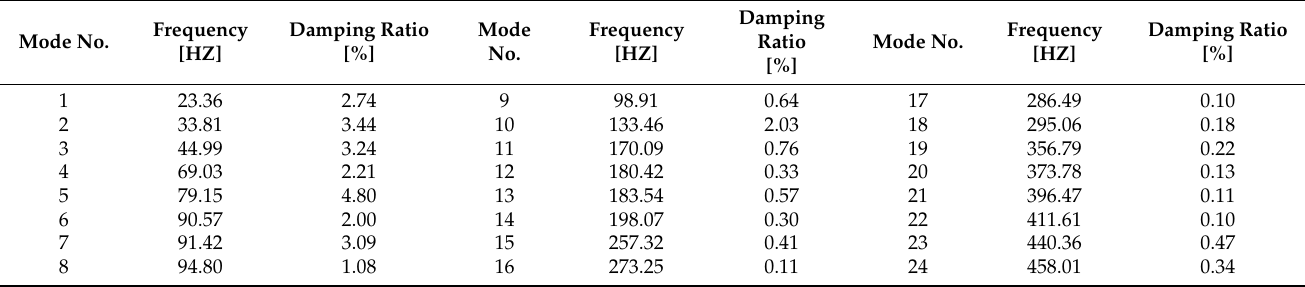
Table 2. List of identified frequencies and damping ratios from OMS during the run-down.